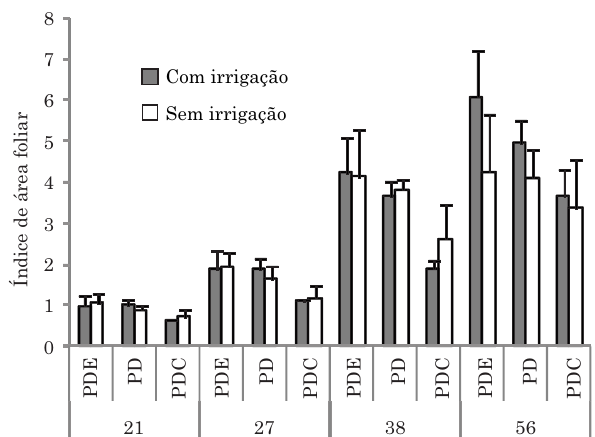
Figura 3. Índice de área foliar da cultura do feijoeiro aos 21, 27, 38 e 56 DAS, em diferentes níveis de compactação, com e sem irrigação. PDE: plantio direto escarificado; PD: plantio direto; e PDC: plantio direto compactado. Barras verticais representam o